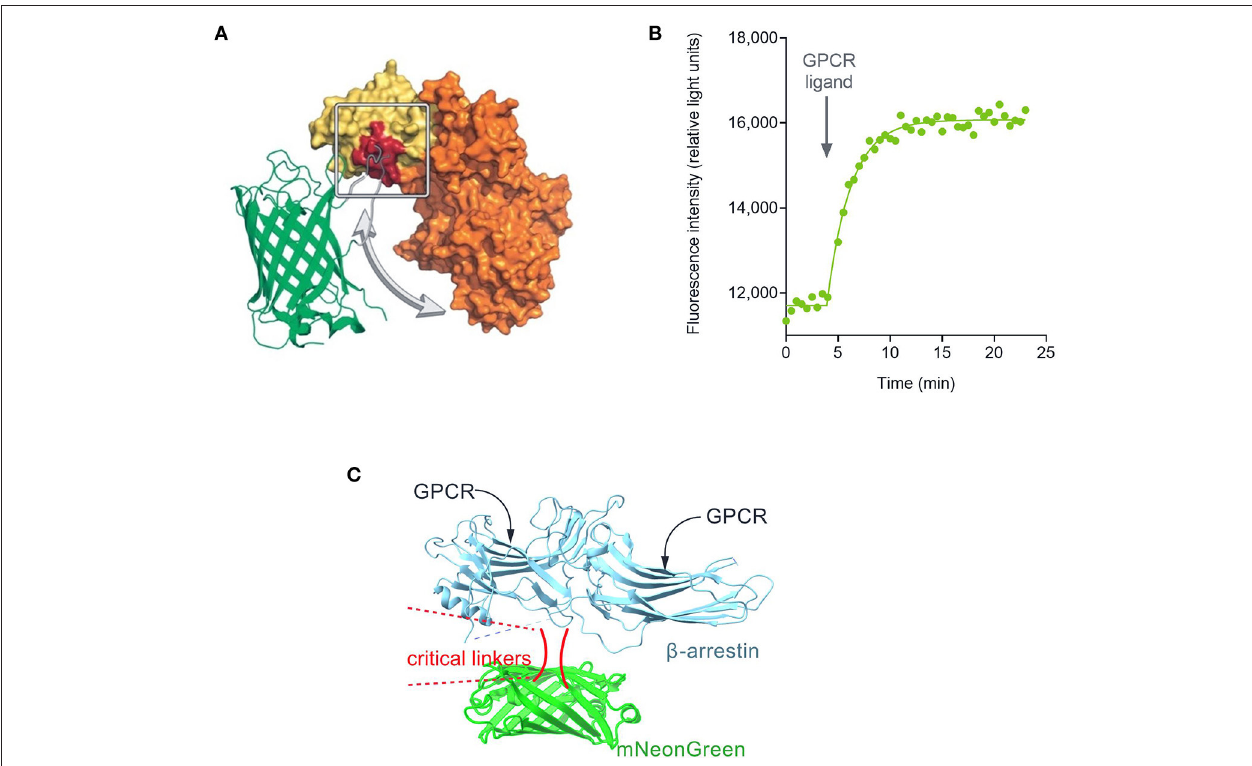
FIGURE 1 | Fluorescent biosensor architecture and function, illustrated using the cADDis cAMP sensor (Tewson et al., 2016). (A) Direct fluorescent biosensors comprise a fluorescent protein (in this case mNeon Green) coupled to a protein that binds the analyte to be detected (in this case EPAC2 binding cAMP). Binding of cAMP to the biosensor causes a change in conformation that results in a change in the optical properties of the fluorescent protein. (B) This change, in this case a change of fluorescence emission intensity, can be recorded in a fluorescence plate reader. (C) Architecture of fluorescent arrestin sensor employed in this study. Arrestin-3 was engineered to incorporate mNeonGreen, as described (Hoare et al., 2020a). Interaction with the receptor causes a change in fluorescence intensity that can be detected in a plate